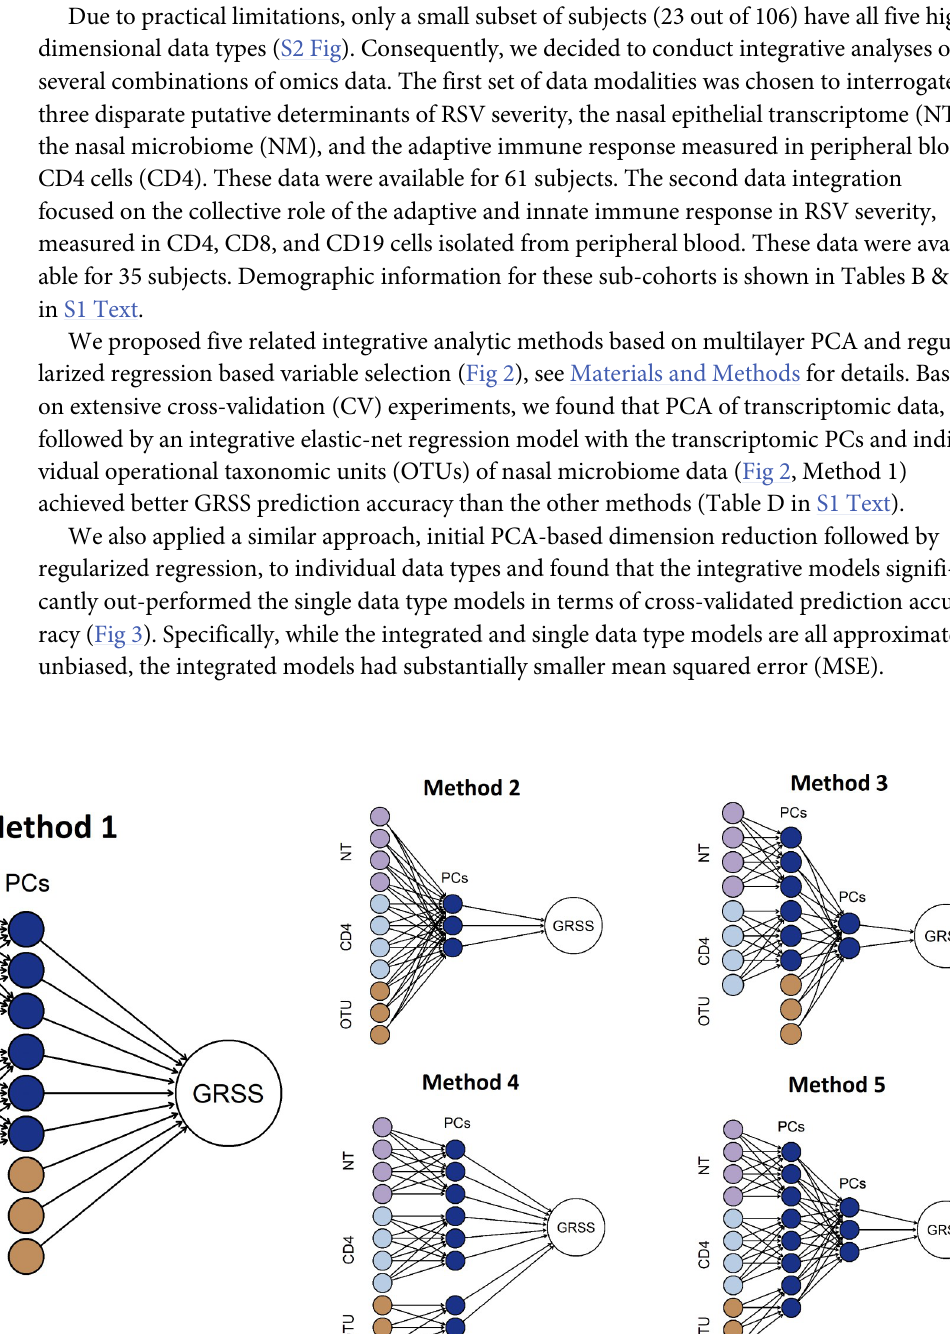
PLOS Computational Biology | https://doi.org/10.1371/journal.pcbi.1009617 December 28,